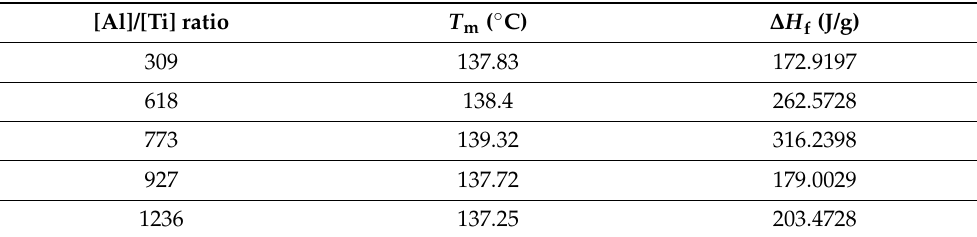
Figure 6. DSC second heating curves for polyethylene with various [Al]/[Ti] molar ratios. Table 3. Melting temperature ( T m ) and enthalpy of fusion ( ∆ H f ) obtained from the DSC of polyethylene with various [Al]/[Ti] molar ratios.